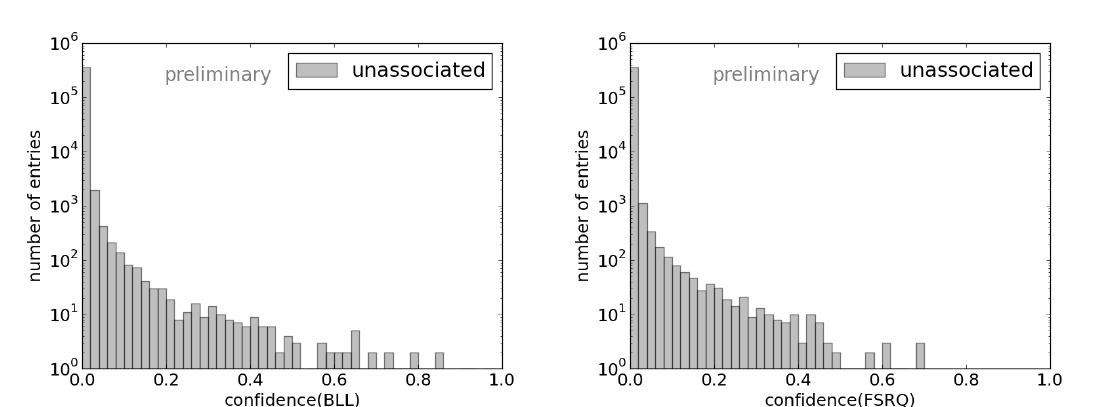
Figure 4. Confidence distribution for the BLL ( left ) and the FSRQ class ( right ). The classification model is applied to the data set of unassociated sources extracted from the 3FGL and the ALLWISE